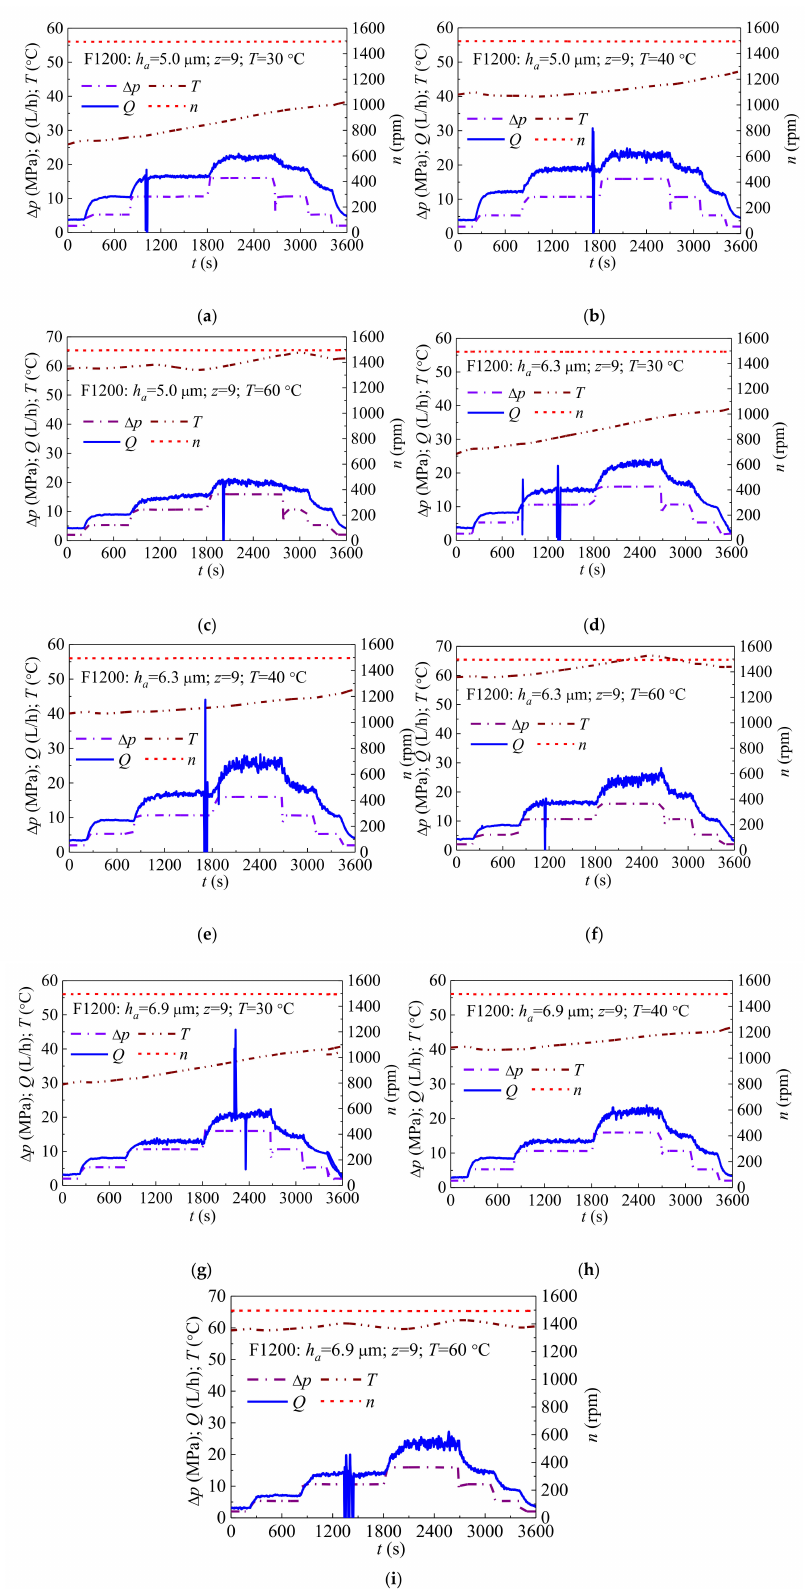
Figure 7. The leakage rate with di ff erent waviness amplitudes, including ( a ) h a = 5.0 µ m, T = 30 ◦ C, ( b ) h a = 5.0 µ m, T = 40 ◦ C, ( c ) h a = 5.0 µ m, T = 60 ◦ C, ( d ) h a = 6.3 µ m, T = 30 ◦ C, ( e ) h a = 6.3 µ m, T = 40 ◦ C, ( f ) h a = 6.3 µ m, T = 60 ◦ C, ( g ) h a = 6.9 µ m, T = 30 ◦ C, ( h ) h a = 6.9 µ m, T = 40 ◦ C, ( i ) h a = 6.9 µ m, T = 60 ◦